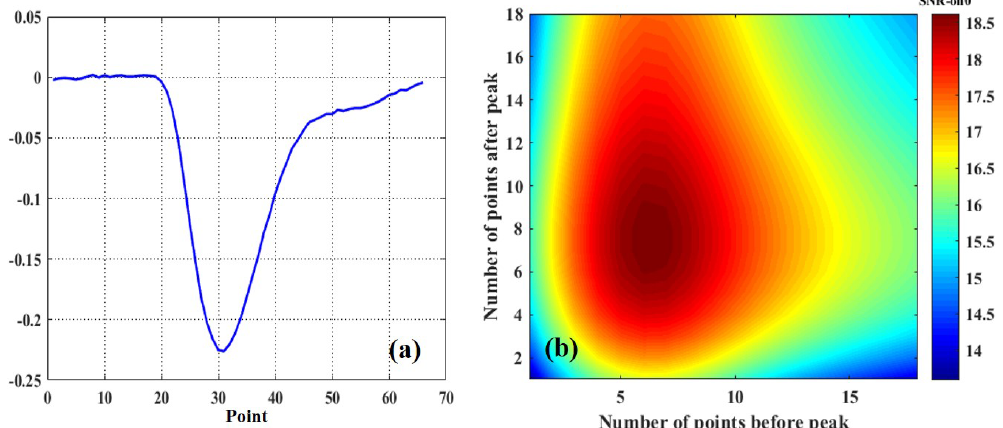
Figure 7. (a) Online wavelength monitoring pulse signal. (b) The change of pulse signal-to-noise ratio (SNR) with the number of selected pulse